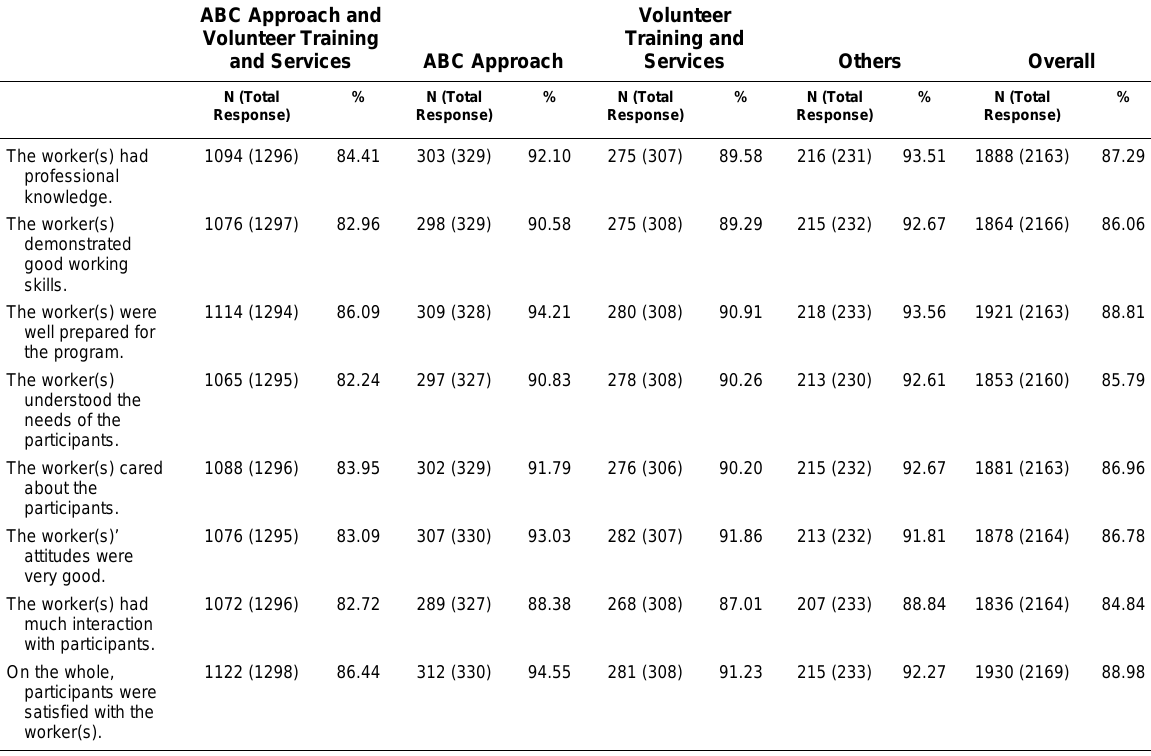
Comparison of the Positive Views Towards Tier 2 Program Workers Among Different Program